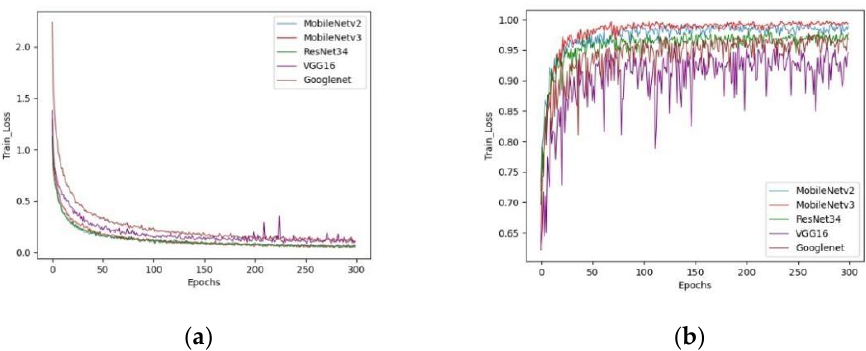
Figure 14. Accuracy and loss curve of different networks. ( a ) Training loss (train_loss). ( b ) Validation accuracy (val_acc). The train_loss of MobileNetV3 is the smallest and the val_acc is the highest.